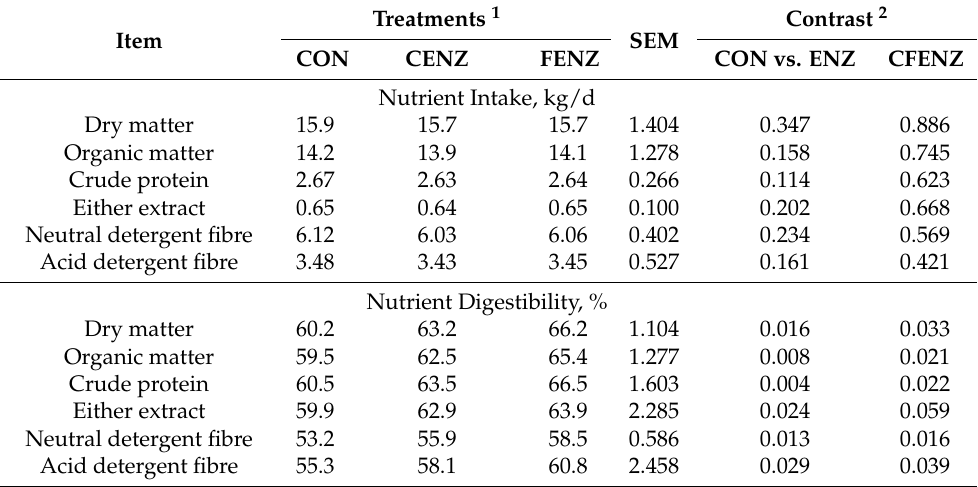
Table 2. Nutrient intake and digestibility of dairy buffaloes as affected by cellulase enzyme supple- mentation to the